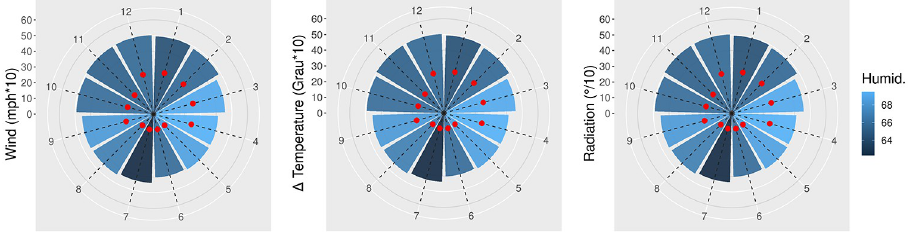
Fig 6. Radar plots: monthly wind variation (left-hand panel), 24-hour temperature variation (middle panel), and monthly solar radiation (right-hand panel). The red dots represent the minimum relative record for each month.